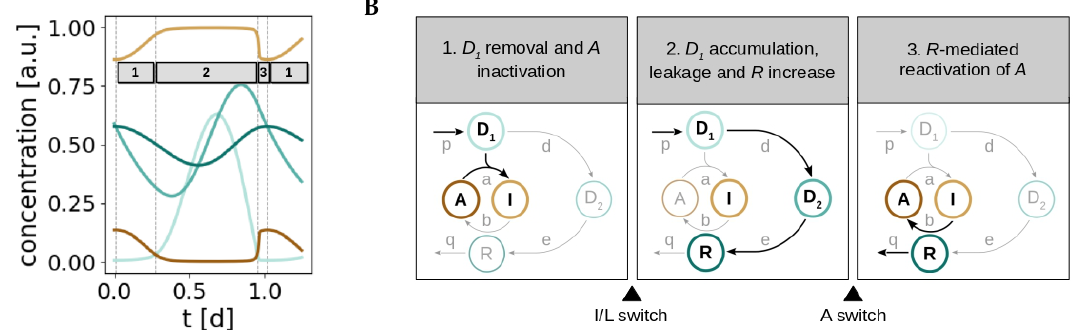
Figure 5. A series of three phases and two temporal switches can be regarded as the mechanism for generation of redox oscillations. ( A ) Division of the temporal dynamics of the I / R system into three phases that explain the major transitions of the model components. ( B ) Scheme of the major events that take place in each phase (see main text for